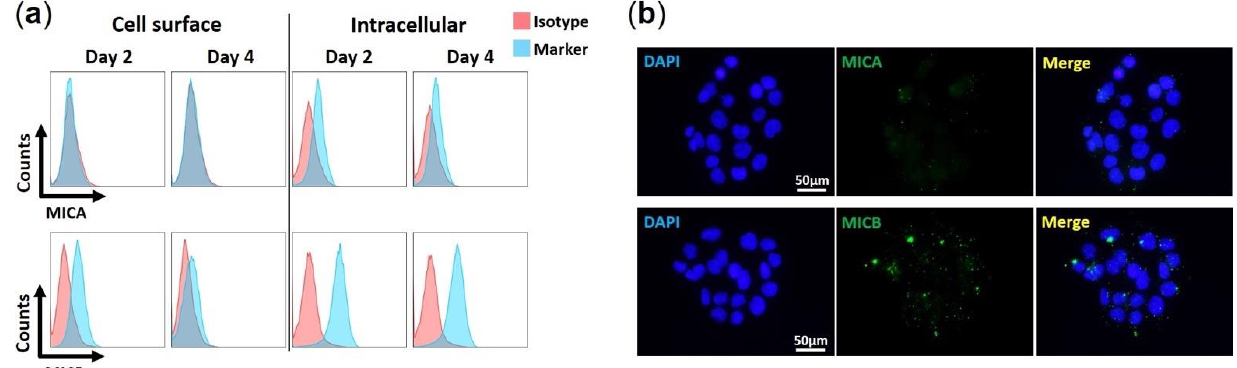
Figure 3. Expression of MIC ligands in uninfected HCT116 cells. ( a ) Flow cytometry histograms showing levels of MIC A and MIC B on the surface and in the intracellular environment of uninfected HCT116 cells. Cells were harvested at day 2 and 4 in culture. Isotype Abs recommended by the manufacturer were used as negative controls. Sample were analyzed on a Gallios (Beckman & Coulter, Brea, CA, USA) flow instrument and analysis was done offline using FlowJo software v10. Histograms are gated on live cells, after exclusion of cell debris and aggregates. ( b ) Immunofluorescence staining of MIC A and MIC B in uninfected HCT116 cells at day 2 in culture, with DAPI in blue and MICs in green. Data are representative of three independent experiments.